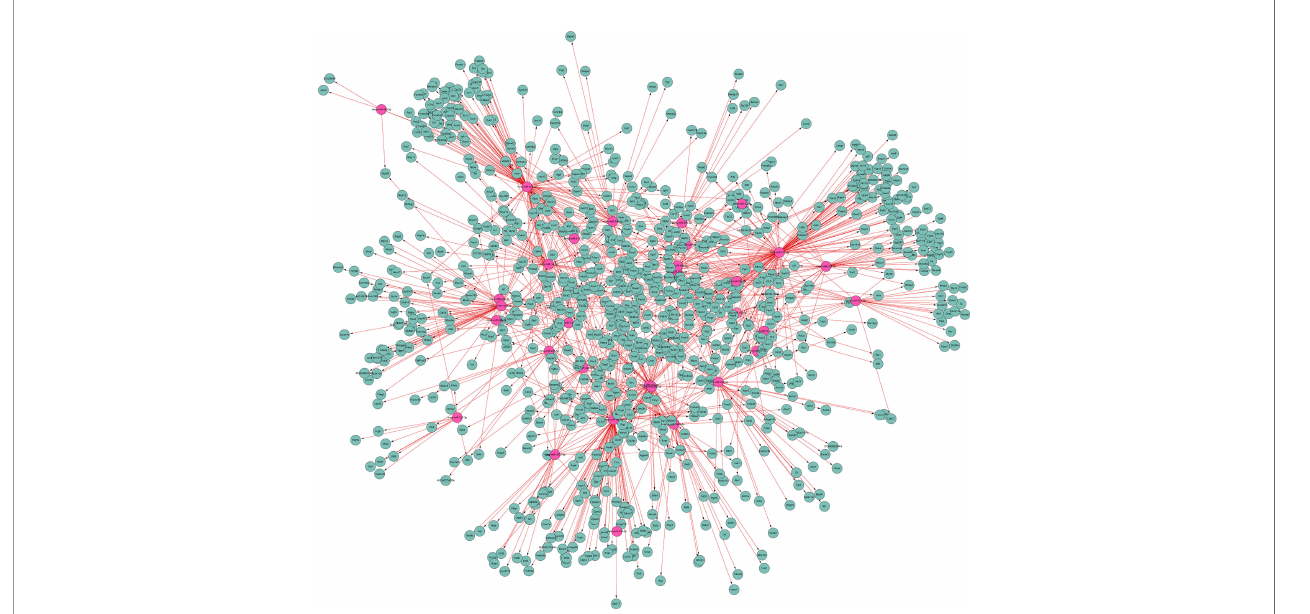
FIGURE 9 | MiRNA-mRNA interaction network. It illustrates the predicted interactions of differential miRNAs with their targets. Red and green represent differential miRNAs and target genes,